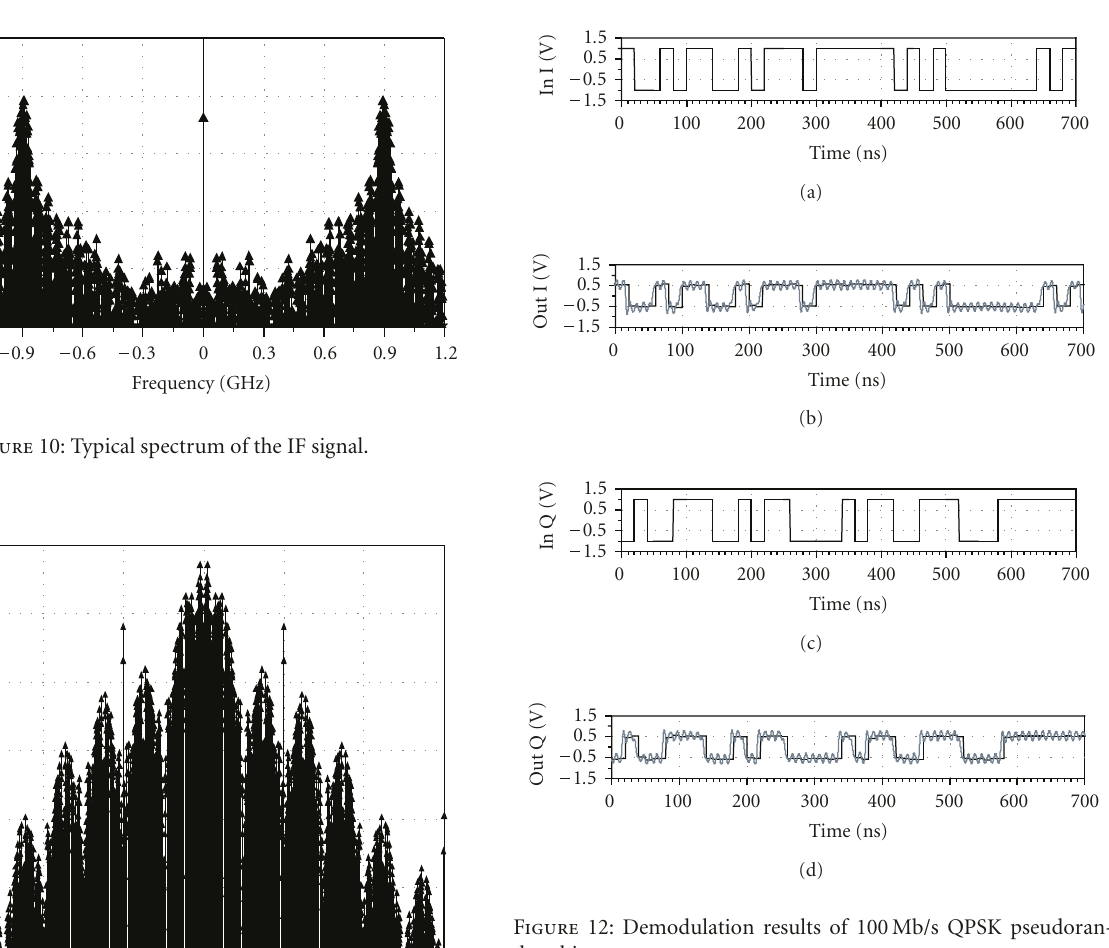
100 MHz represent the clock signal (cid:4)